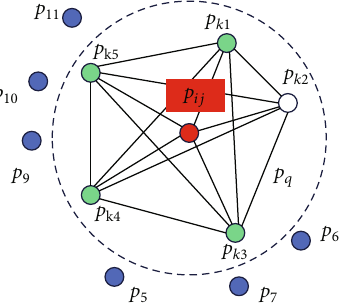
Figure 3: Schematic diagram of the relationship between PFH points.